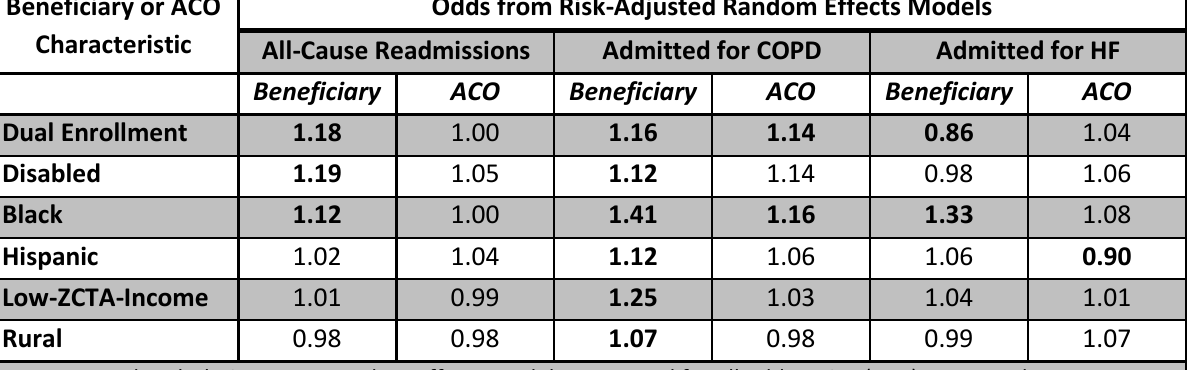
Table 9.7: Beneficiary vs. ACO Factors in Readmissions and Preventable Admissions, 2014 Beneficiary or